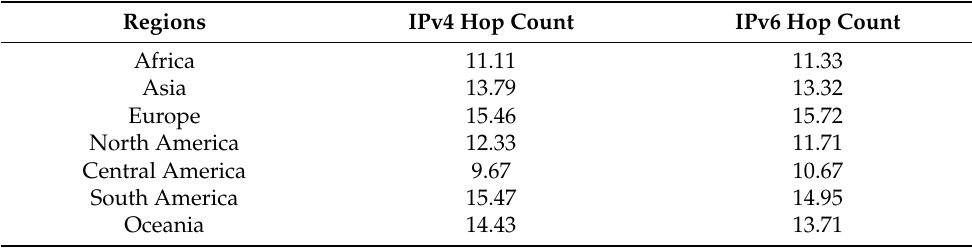
Table 5. Breakdown of average hop count by region.